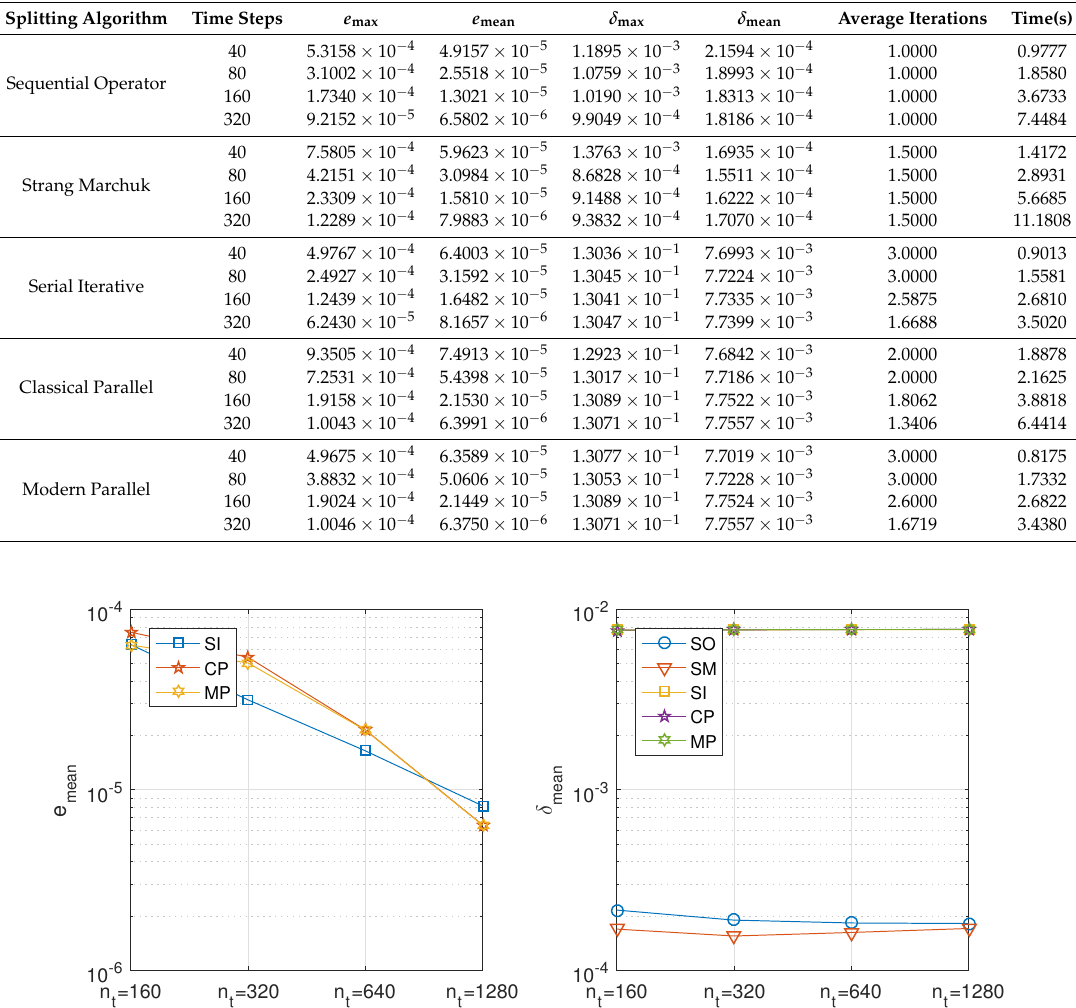
Table 19. Fractional diffusion equation. Results for the balanced decomposition with 20 spatial subintervals and different number of temporal steps.